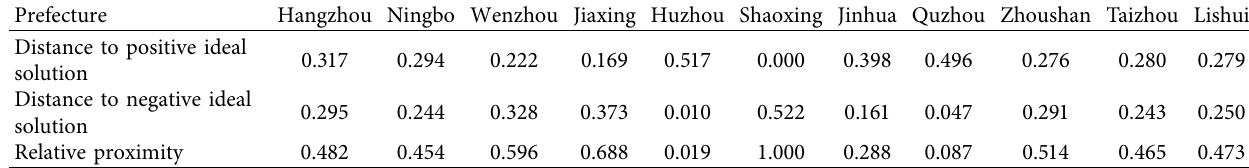
Table 5: Relative proximities of each prefecture.